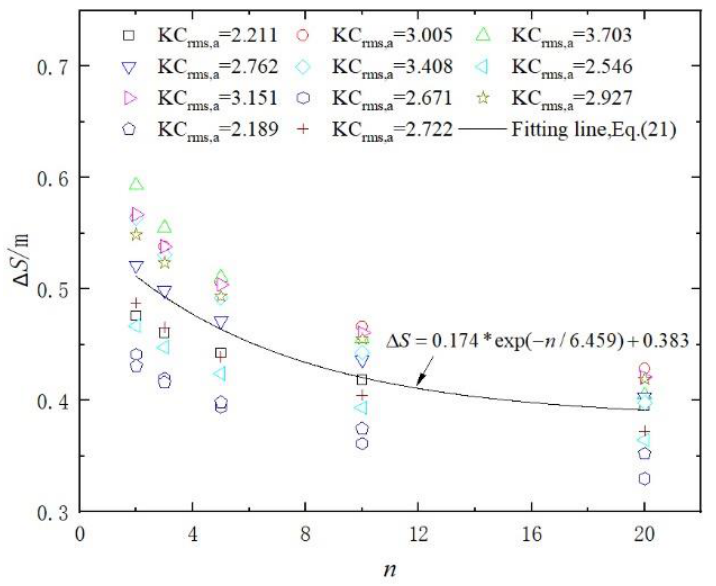
Figure 10. The deviation value ∆ S for different KC rms,a and the fitting results between ∆ S and n .